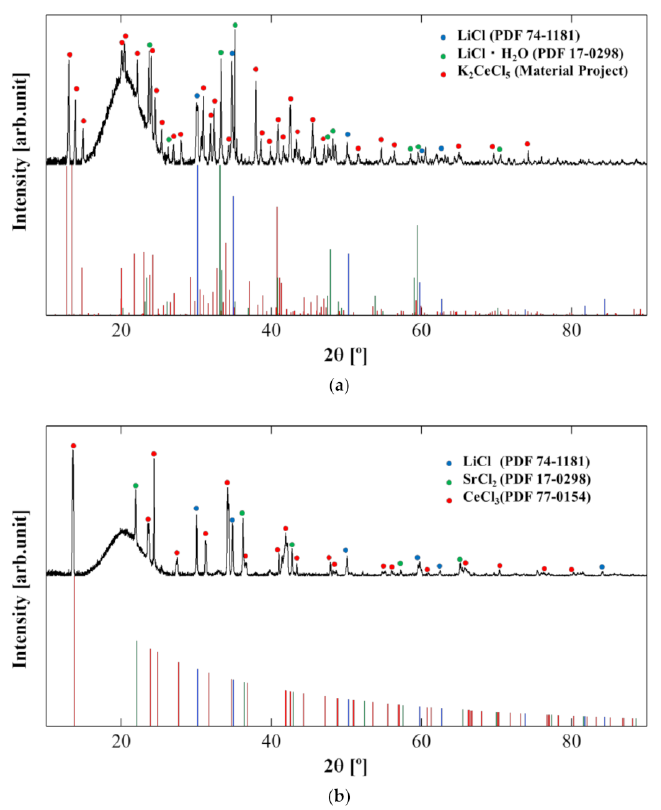
Figure 4. Powder XRD patterns of prepared ( a ) K 2 CeCl 5 /LiCl and ( b ) CeCl 3 /SrCl 2